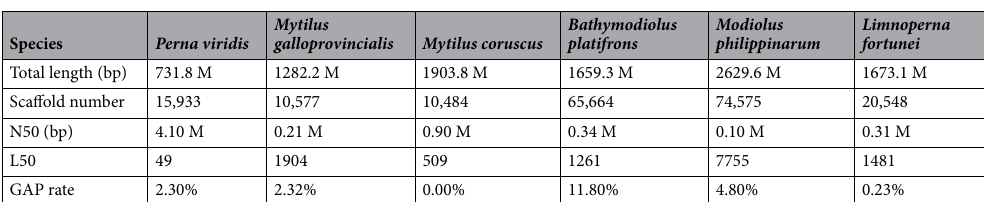
Table 1. Comparison of the sequencing and assembly statistics of the green mussel Perna viridis in the present study with those in other Mytilid mussels reported previously.